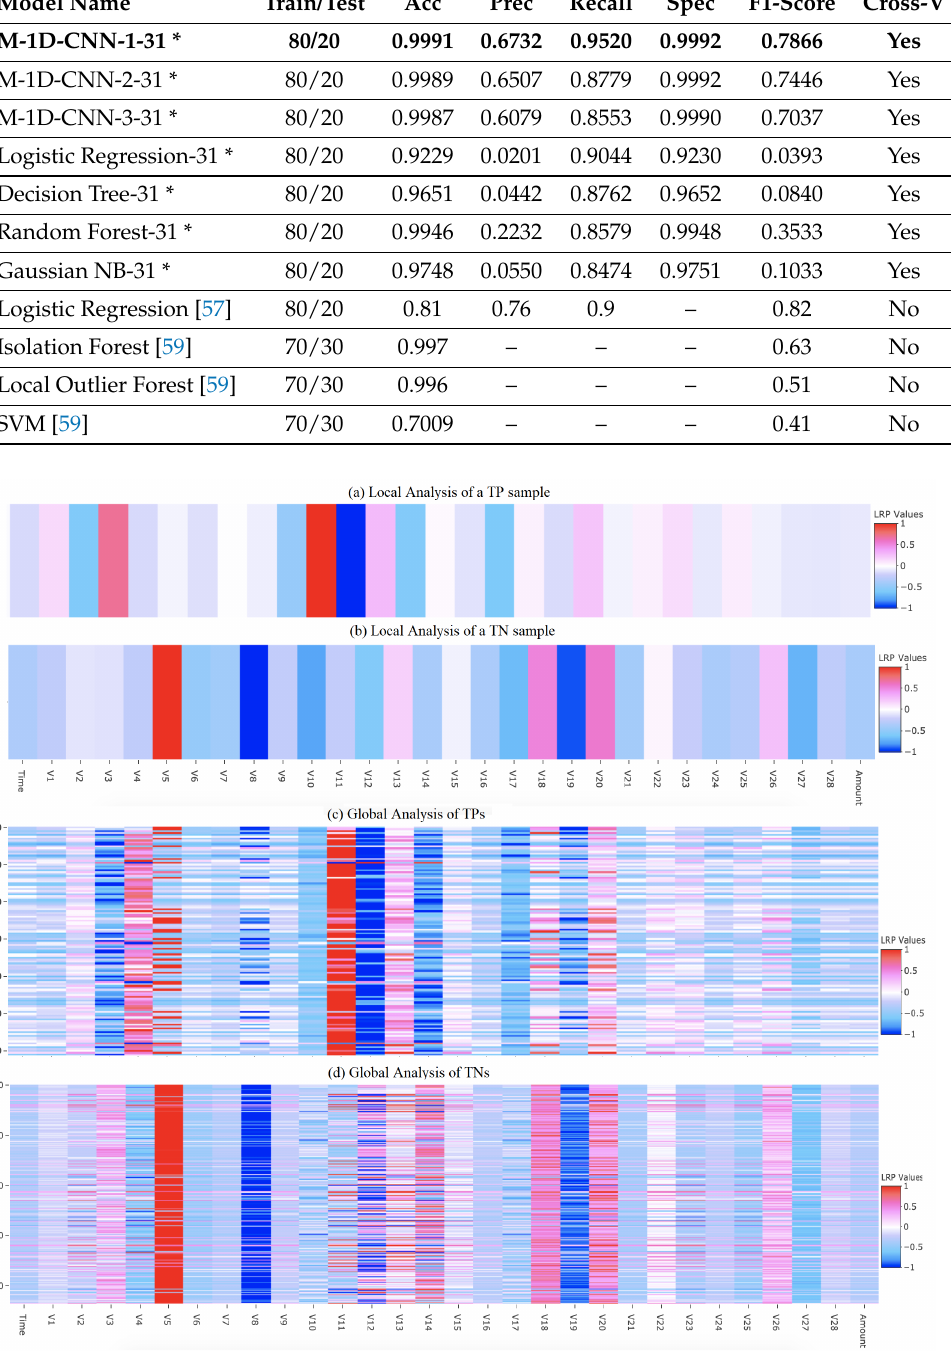
Figure 5. Visualising LRP heatmaps for local (individual) and global (all) TP and TN samples in the CCFDD testing set. Feature sequence of ( a , c ) is similar to ( b , d